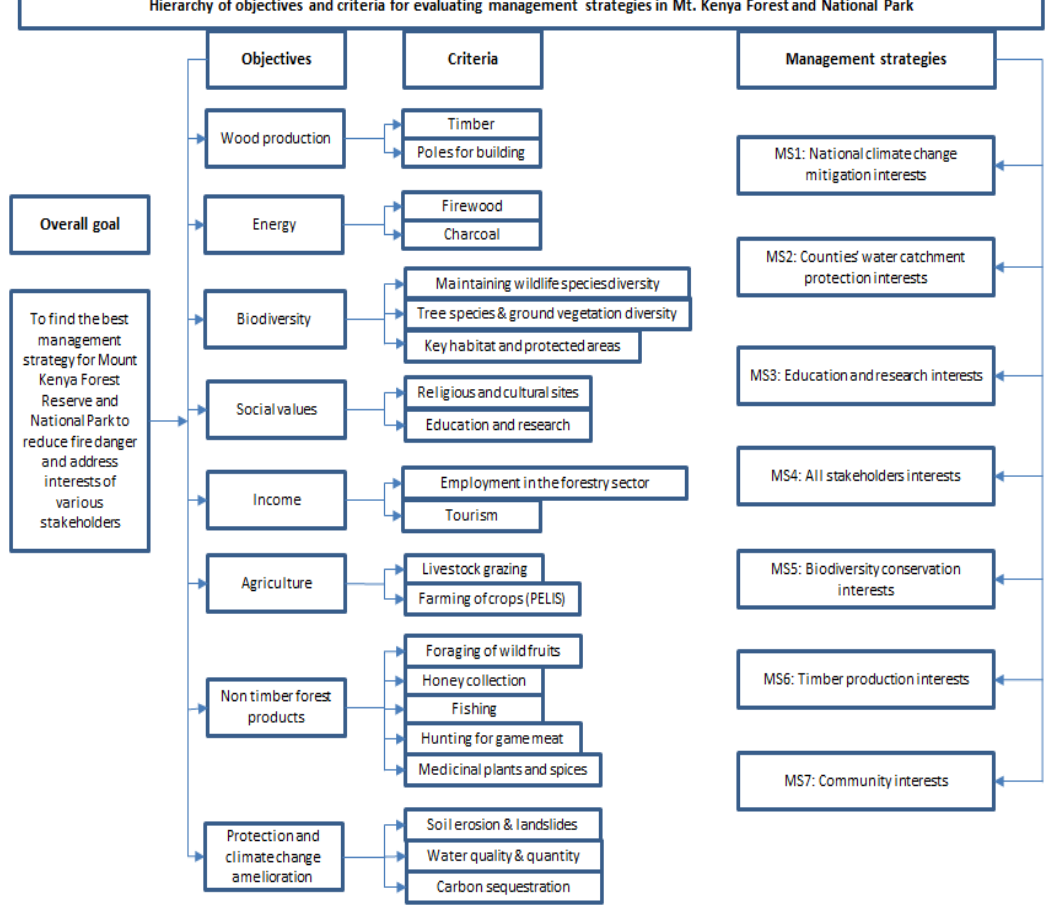
Figure 3. Evaluation hierarchy of the objectives and criteria for selecting the best management strategy in MKFRNP.